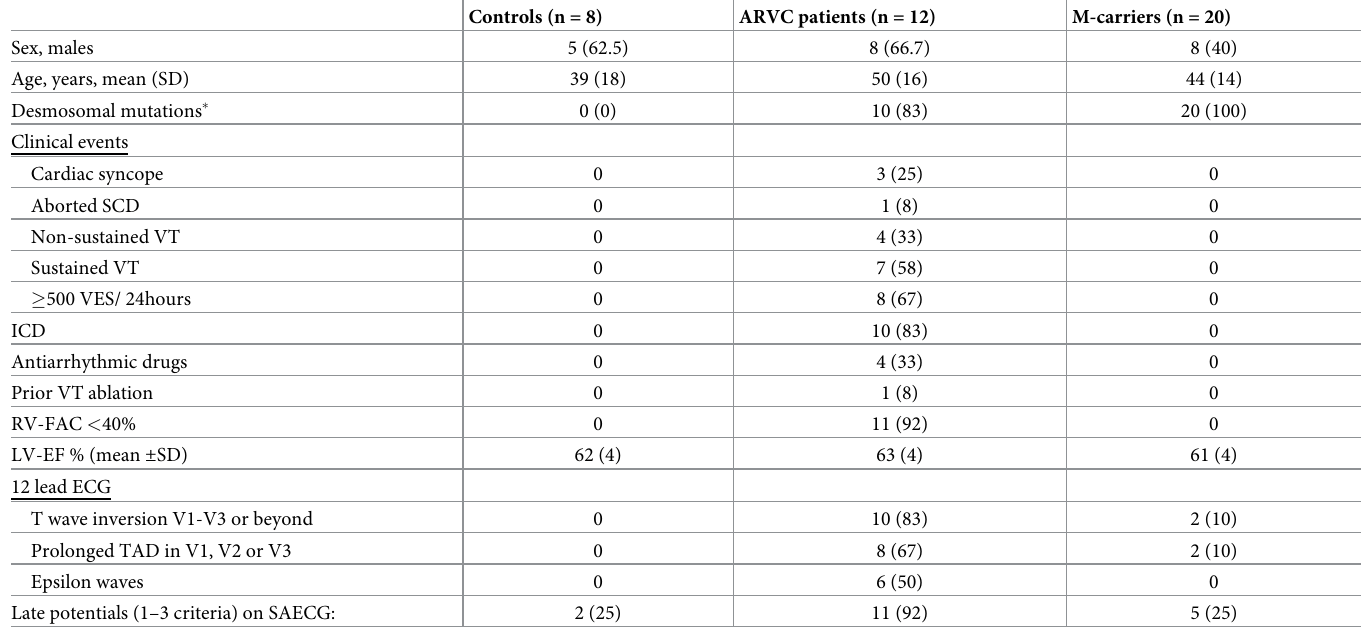
Table 1. Baseline clinical characteristics.